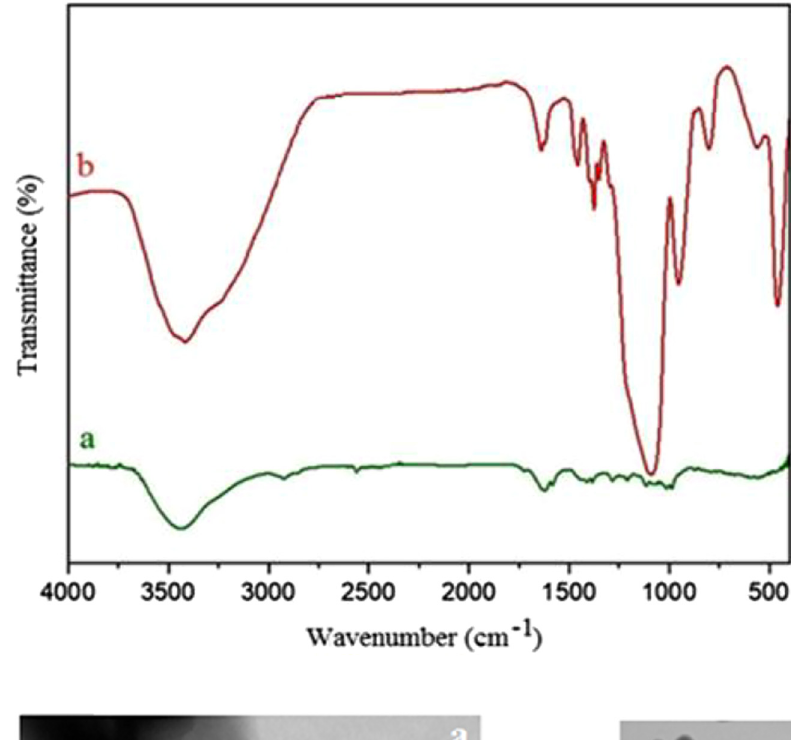
Figure 3: FTIR spectra of (a) SBA-15-SH and